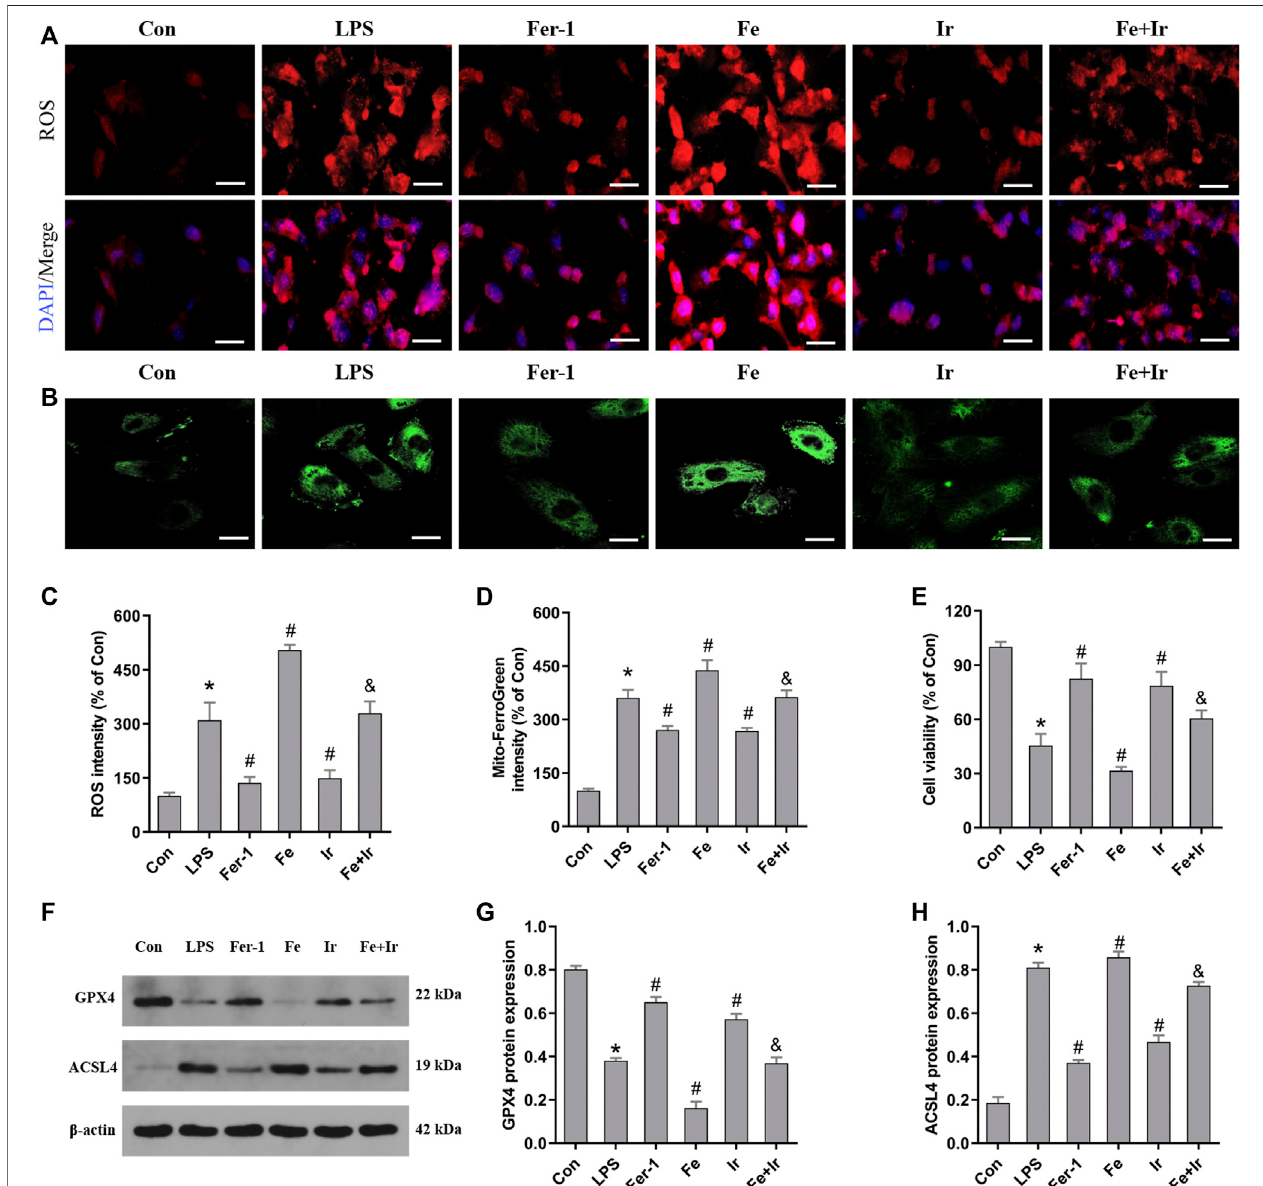
FIGURE3| IrisininhibitsLPS-inducedferroptosisinHK-2cells. (A) ImagesofintracellularROSlevelsinHK-2cellsstainedbyDCFH-DA(10 μ M) fl uorescentprobes (Bar = 50 μ m). (B) Fluorescence images of Mito FerroGreen (5 μ M)-stained HK-2 cells (Bar = 20 μ m). (C) Quantitative results of ROS. (D) Quantitative results of mitochondrial ferrous iron. (E) Cell viability was determined by CCK-8 in HK-2 cells. (F) Western blot analysis of GPX4 and ACSL4 proteins in HK-2 cells. (G,H) , Quantitation of results in (F) . * p < 0.05 vs. Con group, # p < 0.05 vs. LPS group, & p < 0.05 vs. Fe group. Data are presented as mean ± SD ( n = 3).